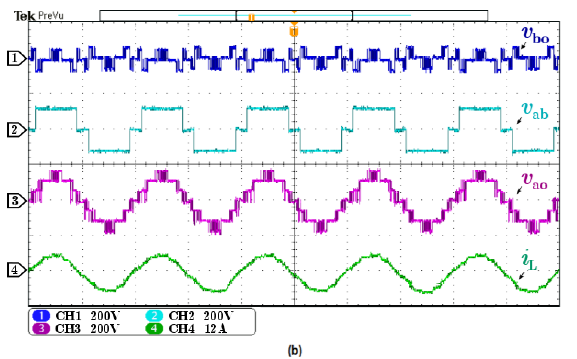
Figure 10. Output voltage of inverter topology for load-A at M = 1.1, ( a ) simulation waveform of respective converter modules and inverter current, ( b ) experimental waveform of respective converter modules and inverter current, traces channel 1, 2, 3 (200 V/div) and 4 (12 A/div).